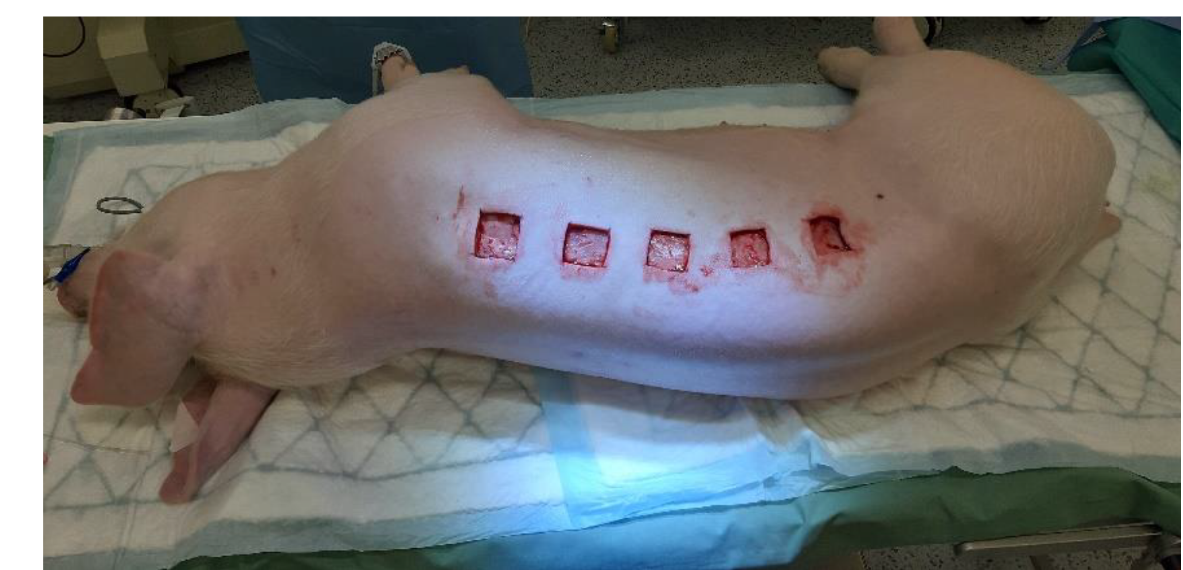
Figure 7. The creation of skin wounds.